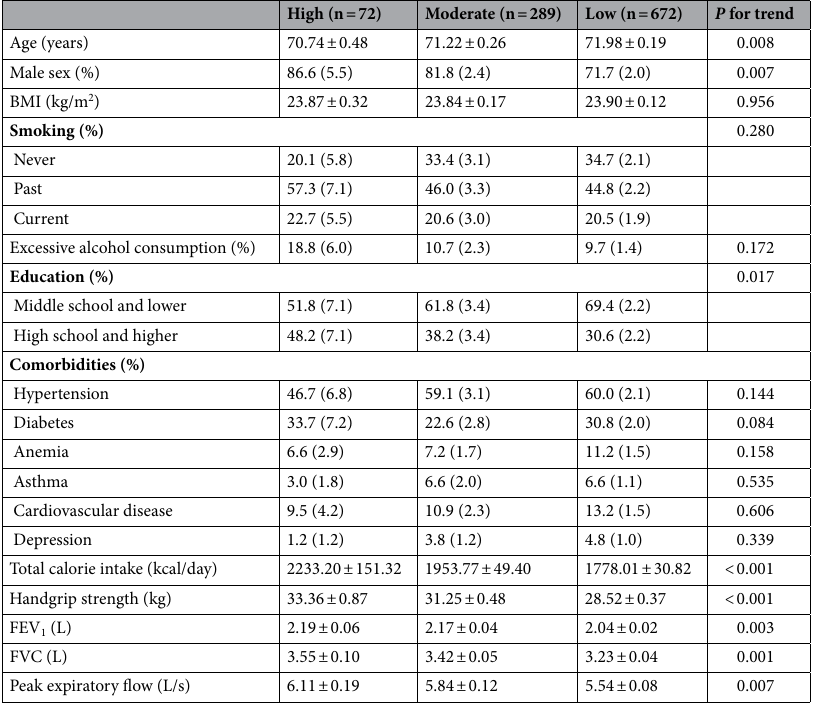
Table 1. Participants’ characteristics according to physical activity level (n = 1033). Data are weighted means ± SE or weighted percentage (SE), as appropriate. BMI, body mass index; FEV 1 , forced expiratory volume in one second; FVC, forced vital capacity.